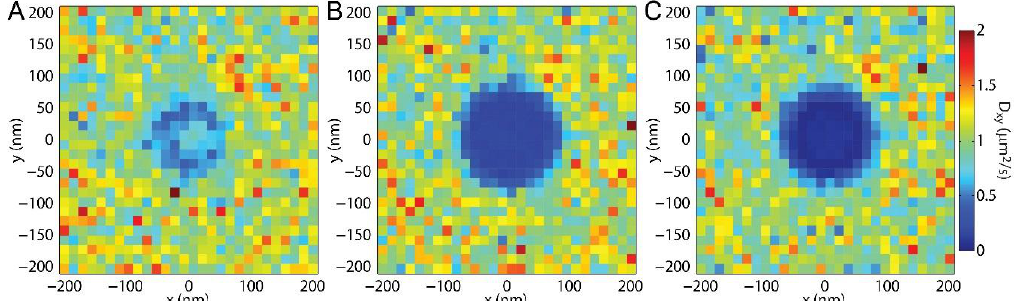
Figure 4. D xy mapped over the sample through single particle tracking (SPT). The single steps from all trajectories are binned according to the average x position and the average y position of the two localizations. This two-dimensional (2D) binning of the x and y positions allows for the analysis of all the step lengths in each region on the sample, as represented by a single pixel in these images. Here, h bud = 100 nm, σ r = 15 nm, D Plane = 1 μm 2 /s, and t frame = 2 ms while ( A ) D Bud = 1 μm 2 /s; ( B ) D Bud = 0.1 μm 2 /s; and ( C ) D Bud = 0.04 μm 2 /s. The bud induced slowing in ( A ) was due to the membrane topography causing the lipid to move slower through the xy- plane with constant local diffusion in the membrane of varying orientation; this effect also contributes to ( B , C ). The distinction between the bud and the planar membrane is enhanced when there is a greater difference between D Plane and D Bud .